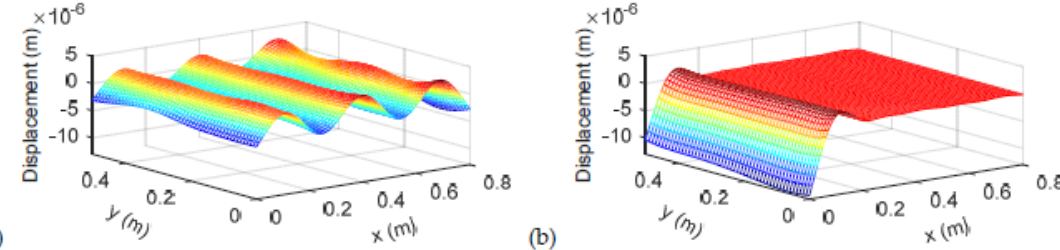
Figure 13. The displacement profiles of ( a ) the mass-loaded plate and ( b ) the locally resonant plate with fully free boundary conditions at 304 Hz.